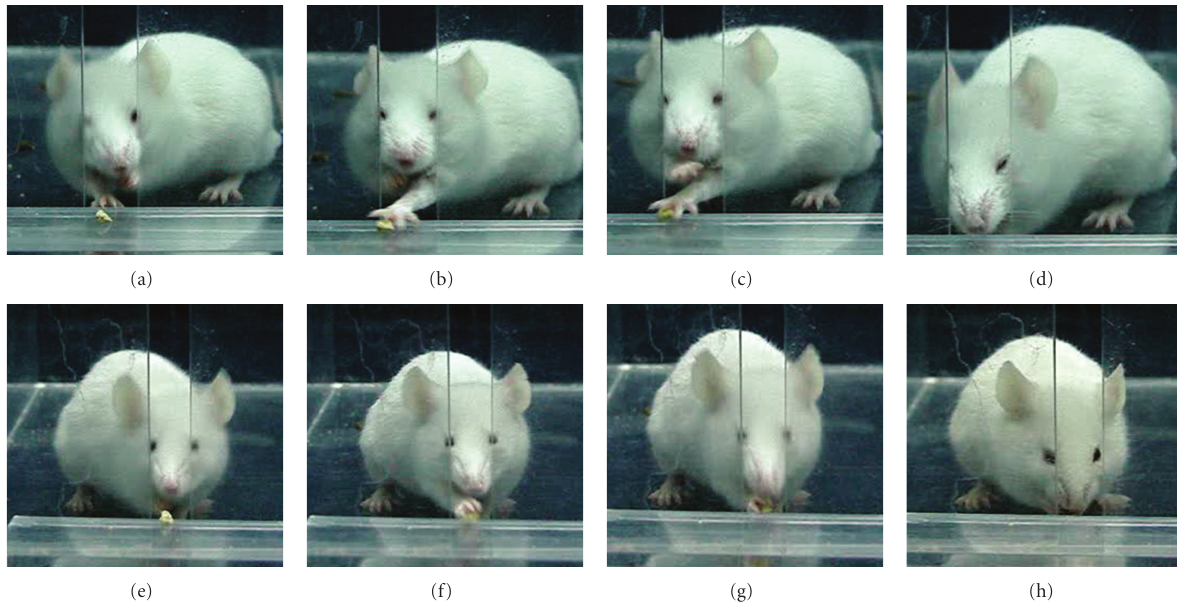
Figure 4: Representative still frames of a Mn-inhaled mouse (a–d) and Mn-inhaled mouse + l -DOPA treatment (e–h). In frames (a)–(d), the mouse showed impairments using extreme postural adjustments advancing the limb diagonally through the slot making many short attempts rather than aligning the limb with the midline of the body. The digits are concurrently adducted. The paw comes in from the side or slaps laterally, and digits do not contact the food pellet. The mouse is dragging its limb through the slot and dropping the pellet to the floor cage chasing the food with the tongue rather than fully pronating the paw and supinating it to present the food to the mouth. In contrast, in frames (e)–(h), the e ff ect of l -DOPA treatment is evident, and the mouse adjusts its posture, directs the arm to the food pellet, and closes its digits to obtain it